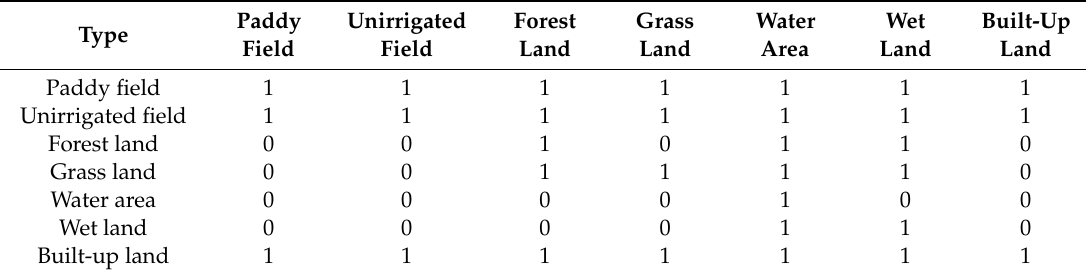
Table 3. Rules of land use type conversion under the ecological optimization scenario.